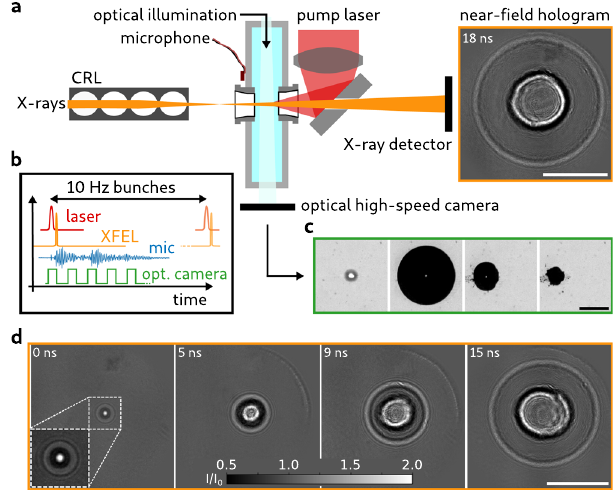
Fig. 1 Holographic imaging of cavitation at the MID instrument. a The FEL X-ray pulses are focused to nanometer spot size by the beryllium CRLs. A cuvette with water is placed behind the X-ray focus. The pump laser is focused by a lens and re fl ected by a subsequent plane mirror into the water to seed the bubble. The X-ray and the laser beam are antiparallel. The X-ray beam passes through a small hole in the laser mirror to the X-ray detector. The distance between X-ray focus and laser focus, i.e., the seeding point of cavitation, is z 01 = 144 mm and between X-ray focus and detector z 02 = 9578 mm. A high-speed optical camera observes the bubble formation